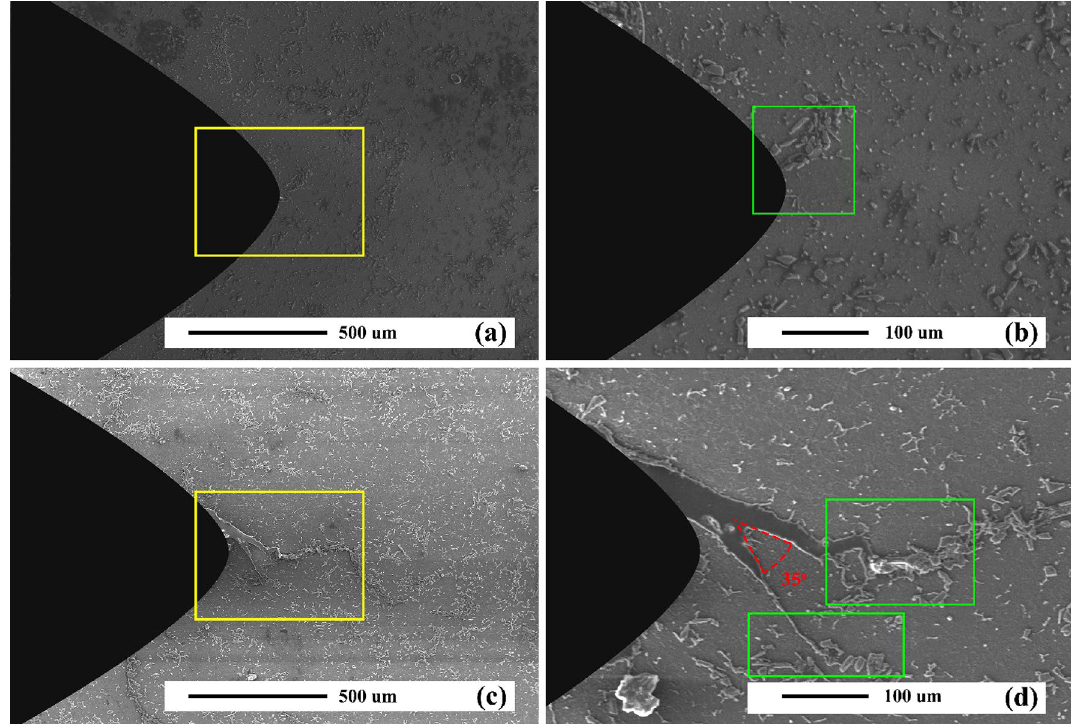
Figure 20. SEM micrograph of as-cast AZ31/5%SiC after thermal cycles at 350 °C ( a ) and ( b ) 900 thermal cycles, and ( c ) and ( d ) 900 thermal cycles.